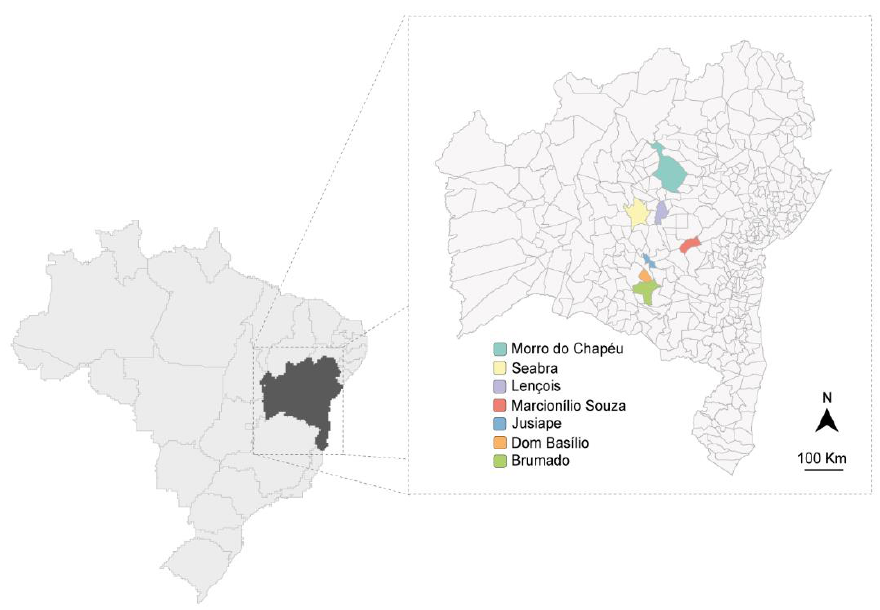
Figure 1. Map of Bahia state in Brazil showing the regions (in color) where plant material was col- lected.